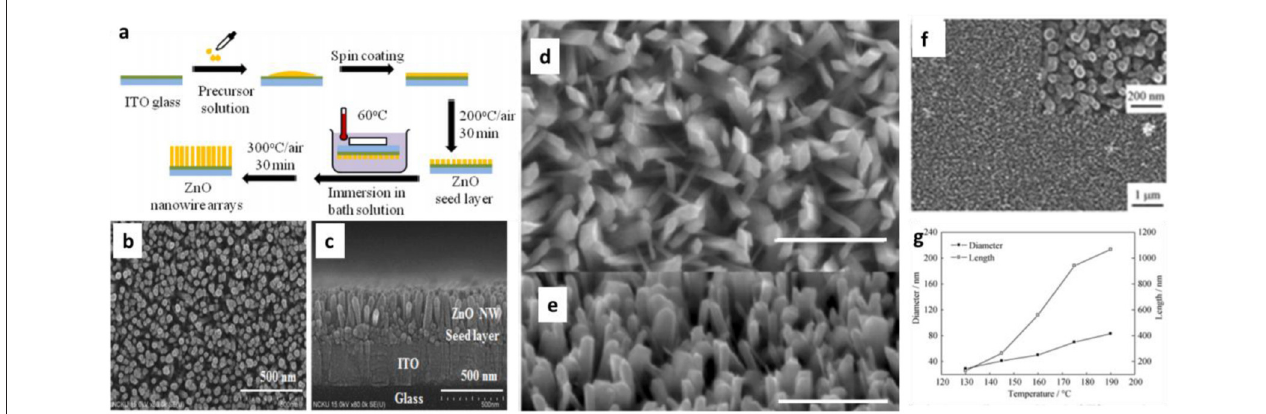
FIGURE 1 | (a) A schematic of synthesis process of the ZnO nanowire arrays on the ITO glass substrate. The SEM images of ZnO NW arrays from (b) top view and (c) lateral view. Reprinted with permission from Chen et al. (2013). copyright (2013) Optical Society of America. (d) SEM image of GaOOH nanowires of (d) Top-view and (e) 45 ◦ tilt-view GaOOH nanowires grown at 150 ◦ C. All scale bars are 1 µ m. Reprinted with permission from Lin et al. (2016). Copyright (2016) American Chemical Society. (f) SEM images of Titanium Dioxide Nano Arrays (TNAs) and localized high-magnification region is attached in the inset figure. (g) The trend of diameter and length vs. temperature of hydrothermal reaction. Reprinted with permission from Li et al. (2010). copyright 2010 the Nonferrous Metals Society of China and Springer-Verlag Berlin